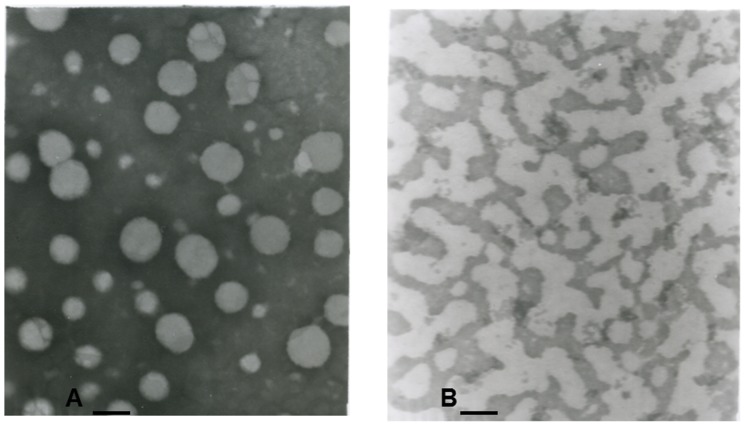
Transmission electron microscopy of vesicular and micellar phases.Bar = 100 nm, JEM-1200Ex. A: General view of cholesterol-phosphatide vesicle. B: General view of micellar phase.